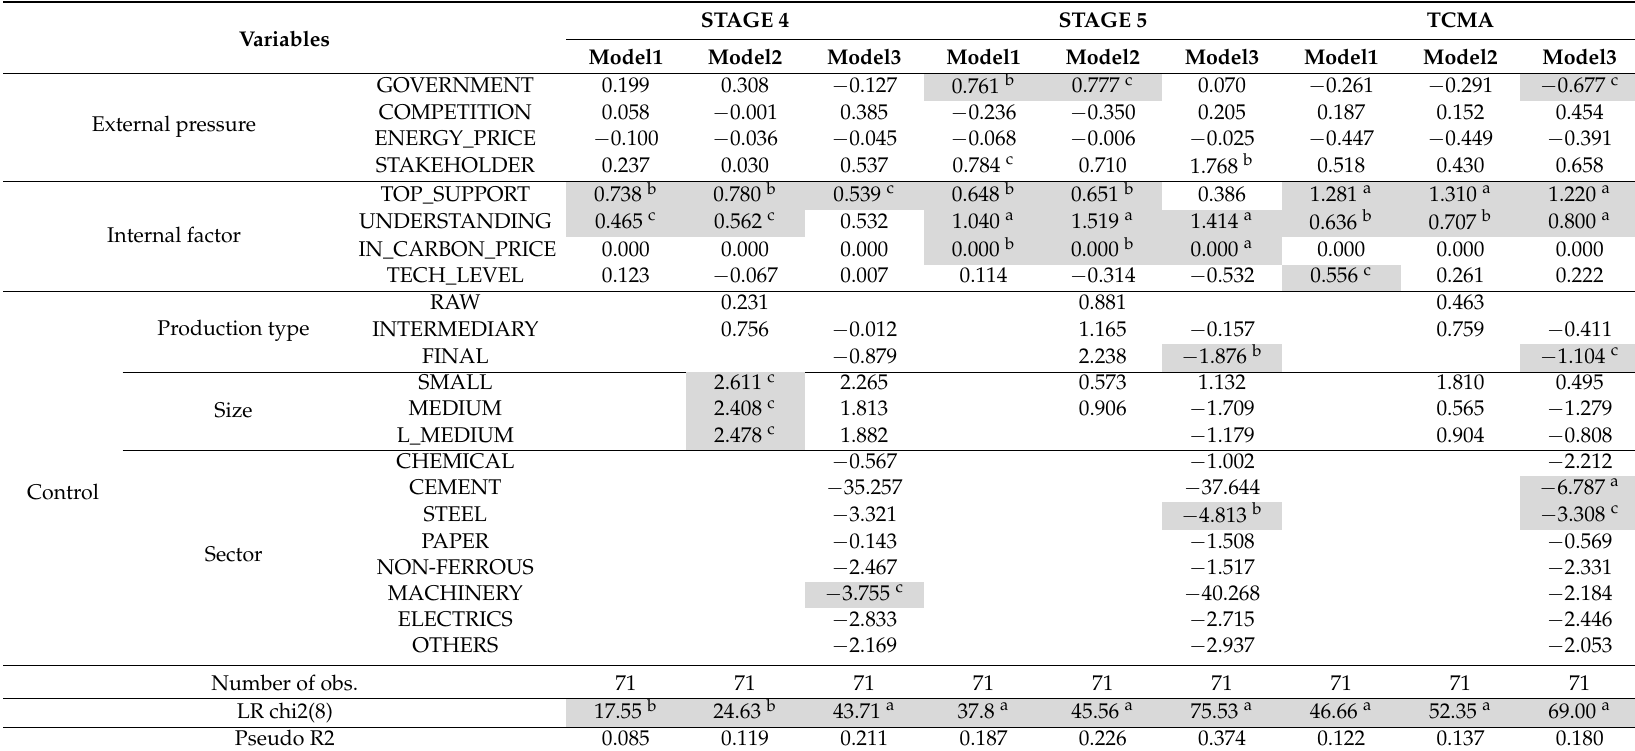
Table 9. Regression result with carbon management of STAGE 4, 5 and